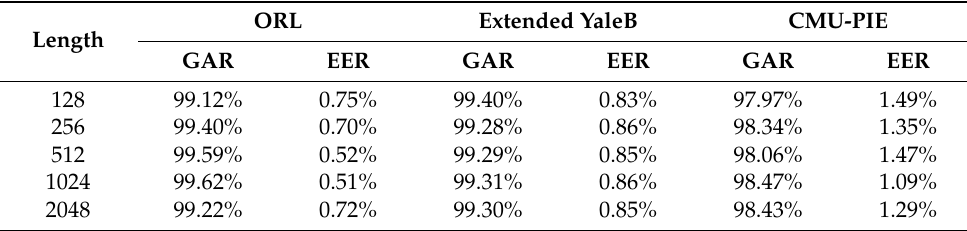
Table 1. Accuracy performance under different key lengths on three benchmark